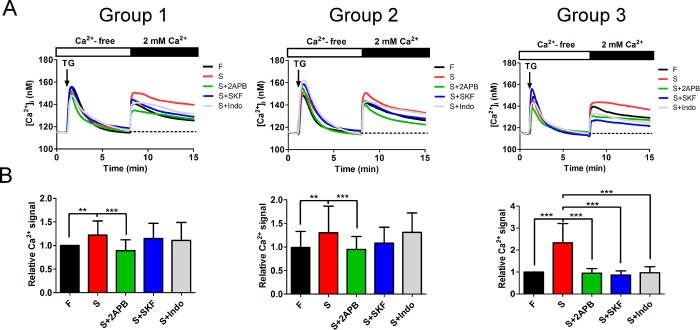
Intracellular Ca2+ elevation from SOCE stimulated the pathological signaling pathways in SSc fibroblasts.(A) Comparison of SOCE activity between normal adjacent fibroblasts and SSc fibroblasts in three groups. After application of thapsigargin (TG) (black arrow) to activate store-operated Ca2+ channels in Ca2+-free balanced salt solution (thick white bar), extracellular CaCl2 was added (thick black bar) to induce intracellular Ca2+ entry. Treatment with the SOCE inhibitors 2-aminoethoxydiphenyl borate (2APB), SKF96365 (SKF) and indomethacin (Indo). These three inhibitors each significantly limited the TG-induced SOCE activity in SSc fibroblasts. (B) Mean area under the intracellular Ca2+ response curves after the addition of extracellular CaCl2 in (A) (n >200 cells; mean ± SD, **, p<0.01; ***, p<0.001).